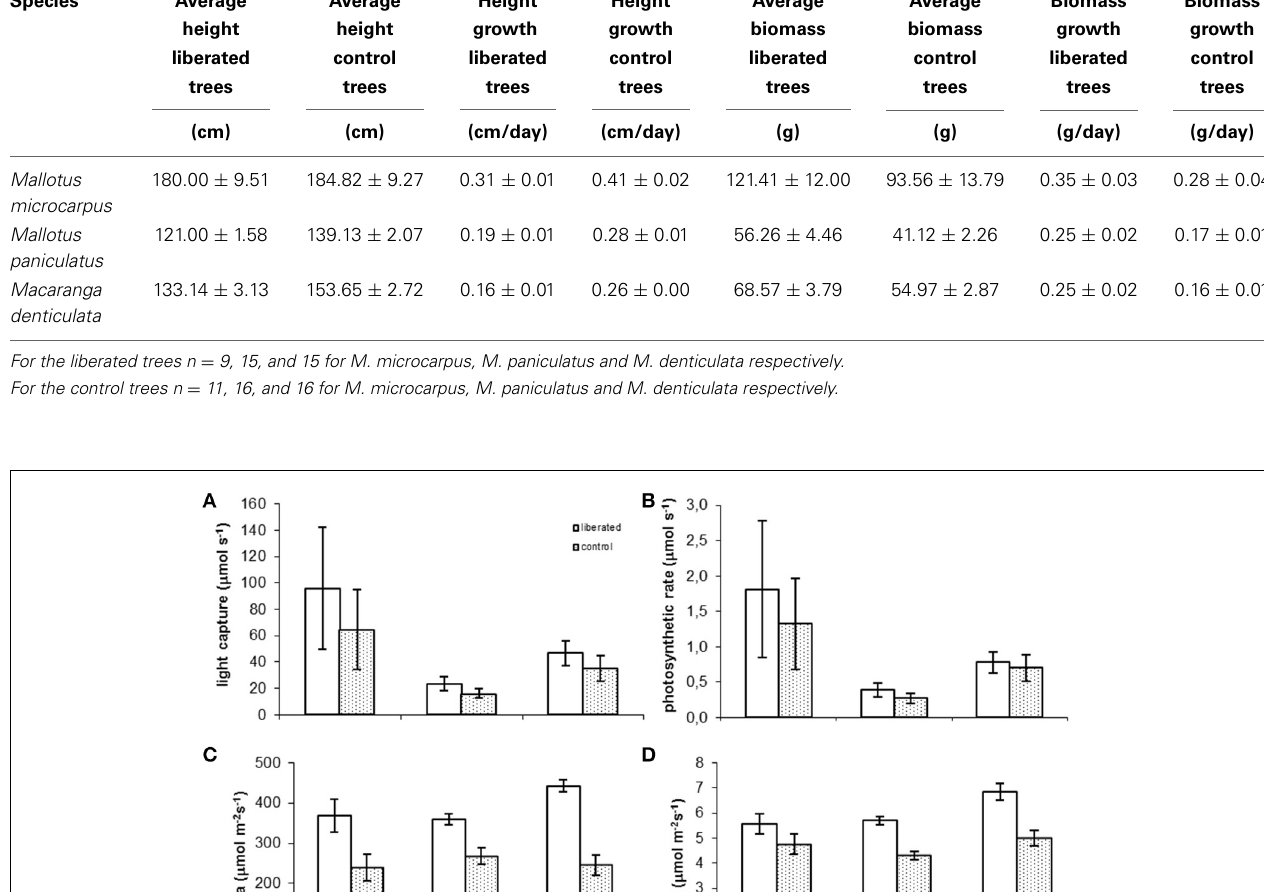
Table 3 | Average growth characteristics of liberated and control trees 174 days after liberation (average values ± SE ). Species